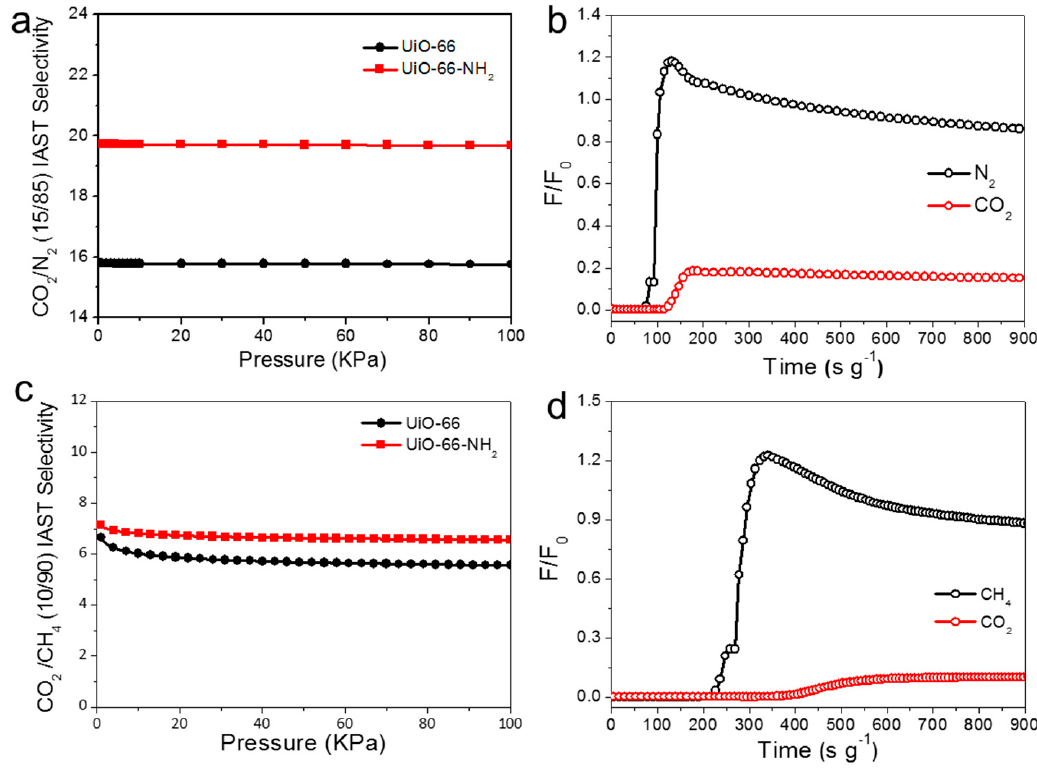
Figure 6. The IAST ( a ) and breakthrough separation curves ( b ) of CO 2 / CH 4 (10 / 90 in volume ration) of UiO-66 and UiO-66-NH 2 ; the IAST ( c ) and breakthrough separation ( d ) curves (s) of CO 2 / N 2 (15 / 85 in volume ration) of UiO-66 and UiO-66-NH 2 .